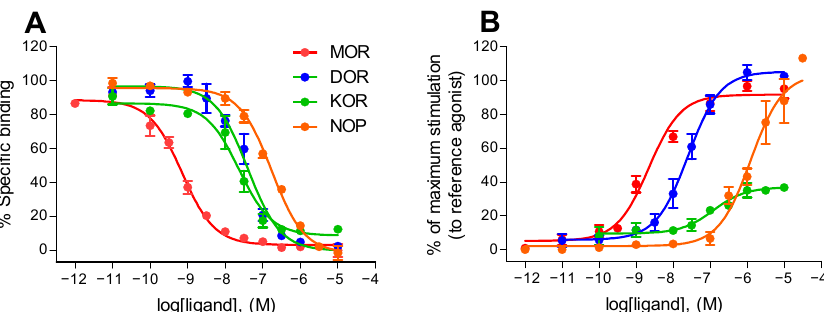
Figure 1. In vitro activity profile of KGNOP1 to the human opioid receptors. ( A ) Binding curves of KGNOP1 to the human opioid receptors determined in competitive radioligand binding assays. Concentration-dependent inhibition by KGNOP1 of [ 3 H]DAMGO (MOR), [ 3 H]diprenorphine (DOR), [ 3 H]U69,593 (KOR), and [ 3 H]Nociceptin (NOP receptor) binding to membranes of CHO cells stably expressing the human opioid receptors (CHO-hOR). ( B ) Concentration-dependent stimulation of [ 35 S]GTP γ S binding by KGNOP1 in the [ 35 S]GTP γ S binding assays using CHO cell membranes stably expressing the human opioid receptors. Data are presented as percentage stimulation relative to the maximum effect of reference full agonists DAMGO (MOR), DPDPE (DOR), U69,593 (KOR), and nociceptin (NOP receptor) (as 100%). Values are expressed as the mean ± SEM (n = 3–4 independent experiments performed in duplicate). Table 1. Binding affinities and functional activities of KGNOP1 to the human MOR, DOR, KOR, and NOP receptors.